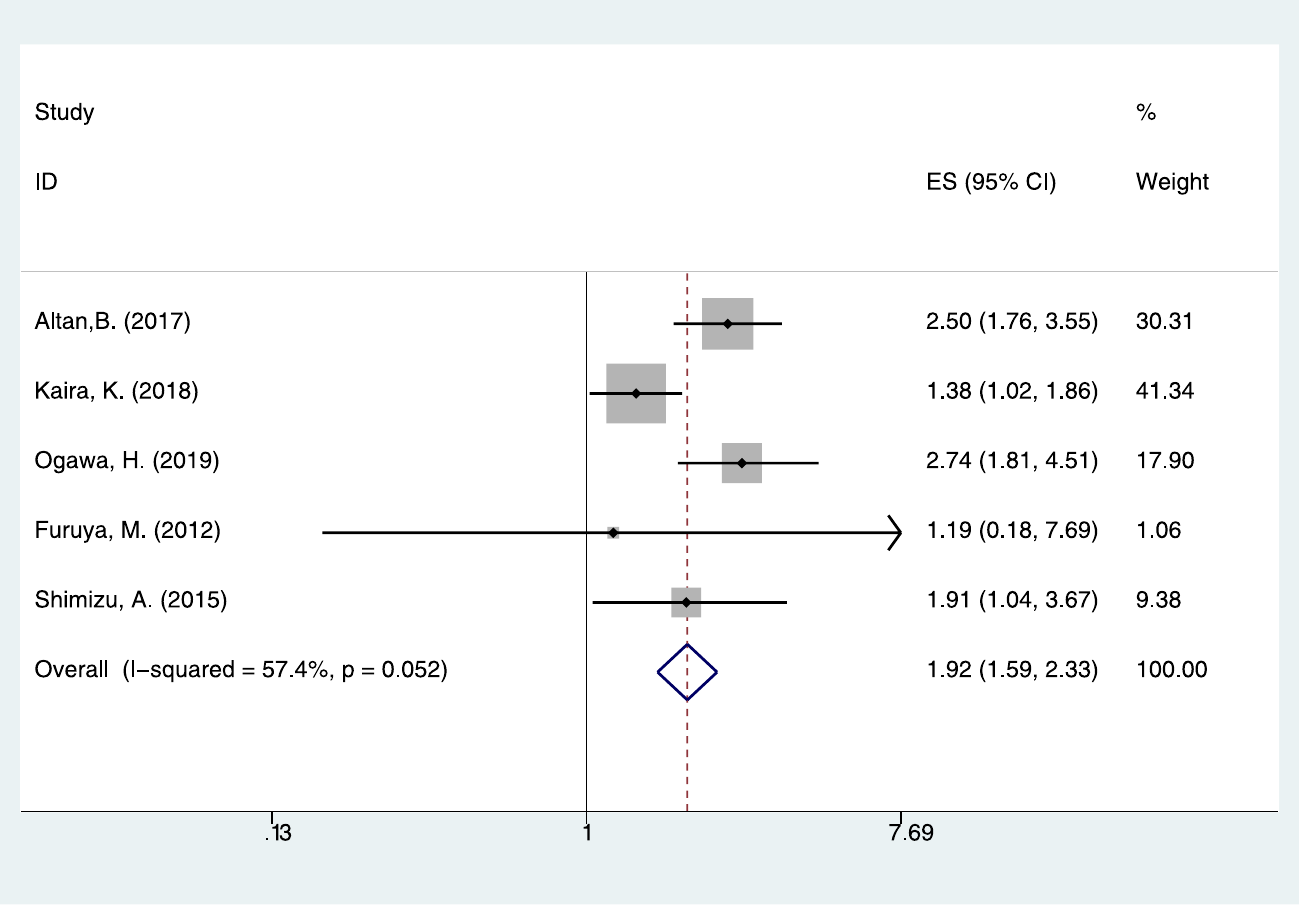
correlation between LAT1 high expression solid cancers and poor OS (pooled HR = 1.848, 95% CI = 1.620–2.108, P < 0.001) (Fig 2). Examining five DFS, the p value and I 2 value of het- erogeneity test report were 0.052 and 57.4%, respectively. The pooled HR and 95% confidence